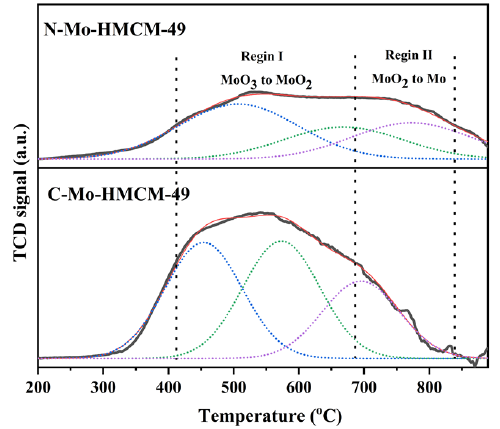
Figure 7. H 2 -TPR profiles of the C-Mo-HMCM-49 and N-Mo-HMCM-49 catalysts. The Mo 3d region XPS spectra of the C-Mo-HMCM-49 and N-Mo-HMCM-49 catalysts before and after reaction under CH 4 flow at 700 ◦ C for 30 and 430 min are shown in Figure 8. Molybdenum carbide (Mo 2 C) dispersed in zeolite channels is the active site of C-H bond activation, and is formed during the induction stage of the MDA reaction process [5,43]. It can be observed that the Mo 3d binding energies at 236.6 and 233.4 eV can respectively be assigned to the Mo 6+ (3d 3/2 ) and Mo 6+ (3d 5/2 ) molybdenum oxide species for fresh catalysts, whereas the binding energy at 228.9 eV can be attributed to the molybdenum carbide species (Mo 2 C) formed for the catalysts after the reaction under CH 4 flow at 700 ◦ C for 30 and 430 min. This can be clarified by the dispersion of Mo oxidation state, which can be observed to be 24.8% (Mo 2 C), 39.8% (Mo 6+ , 3d 5/2 ) and 35.4% (Mo 6+ , 3d 3/2 ) for N-Mo-HMCM-49 catalyst after the reaction under CH 4 flow at 700 ◦ C for 30 min, and 18.1% (Mo 2 C), 54.4% (Mo 6+ , 3d 5/2 ) and 27.5% (Mo 6+ , 3d 3/2 ) for N-Mo-HMCM-49 catalyst distribution observed is 9.5%/8.7% (Mo 2 C), 57.4%/53.3% (Mo 6+ , 3d 5/2 ) and 33.1%/33.1% higher for the N-Mo-HMCM-49 catalyst, which indicates a higher degree of carburization. Furthermore, the sample of N-Mo-HMCM-49 clearly exhibits good dispersion of carbine clusters (MoC x ) after the reaction under CH 4 flow at 700 ◦ C for 430 min, as shown in Figure 9. Gao et al. demonstrated different molybdenum carbide (Mo x C y ) structures and their anchoring inside ZSM-5 channels on the basis of theoretical studies [44]. The results of the XPS and TEM analysis clearly confirm that the higher degree of carburization for N-Mo-HMCM-49 can be ascribed to the higher concentration of MoO x species anchored inside the channel of